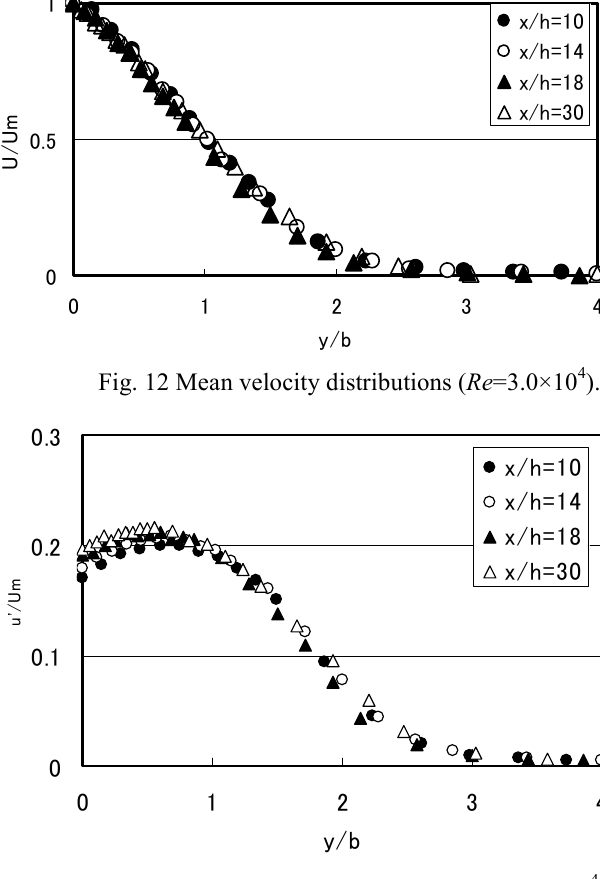
Fig. 13 Fluctuation velocity distribution ( Re =3.0×10 4